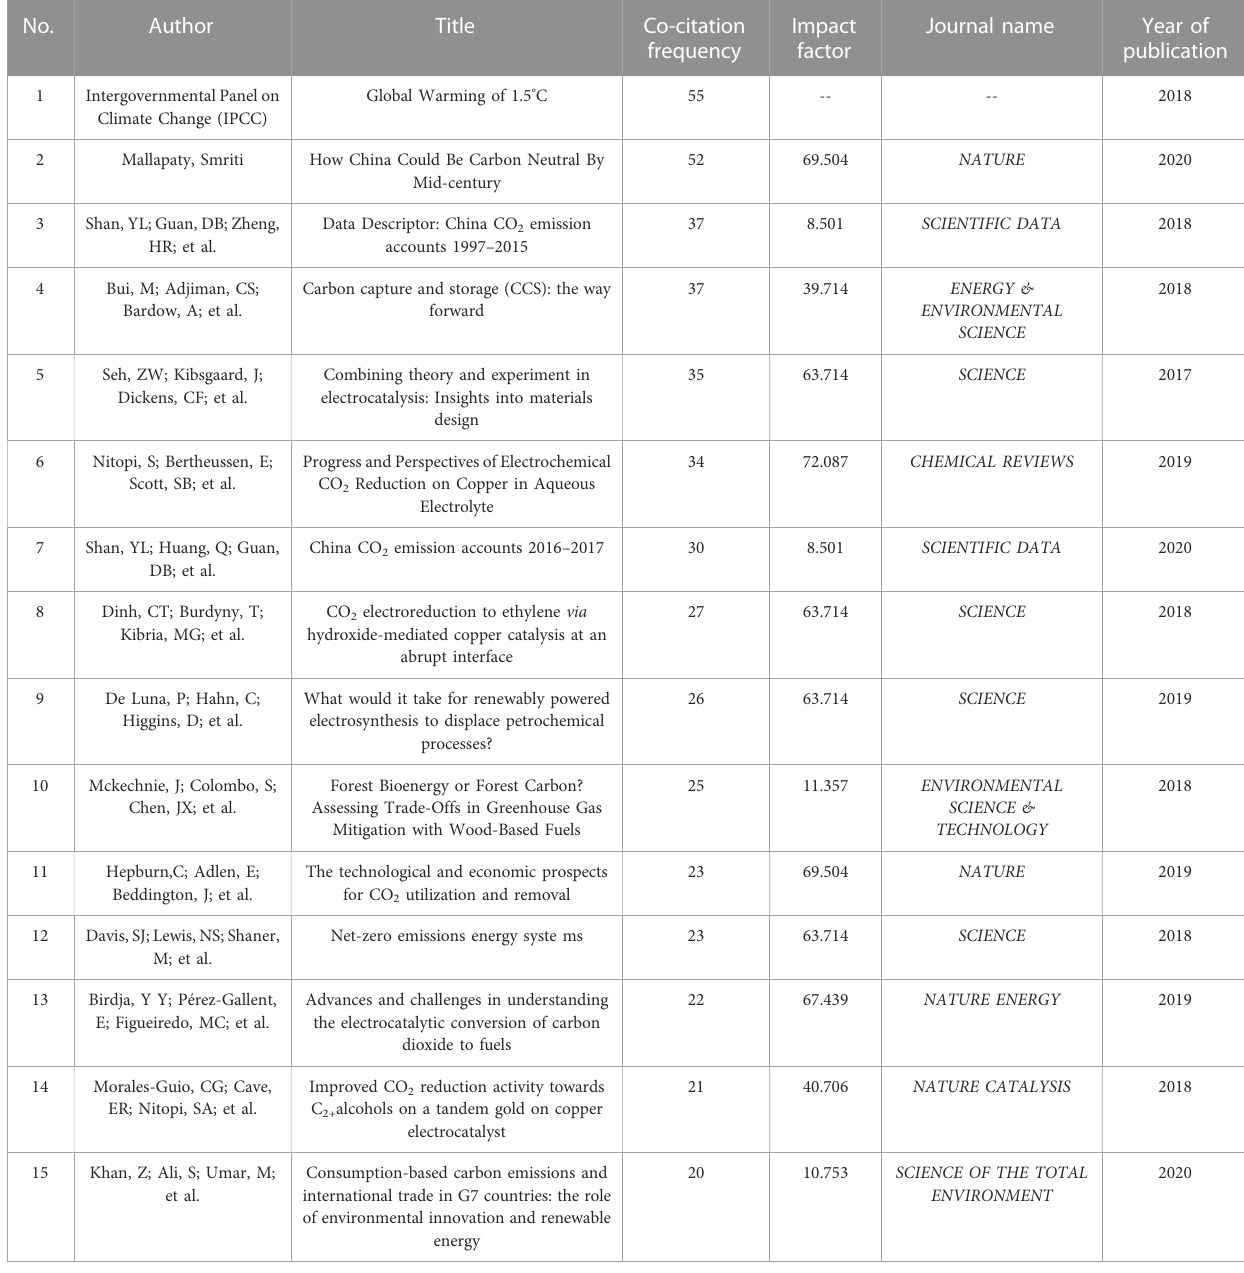
TABLE 3 Statistical analysis of highly Co-cited literature (top 15).